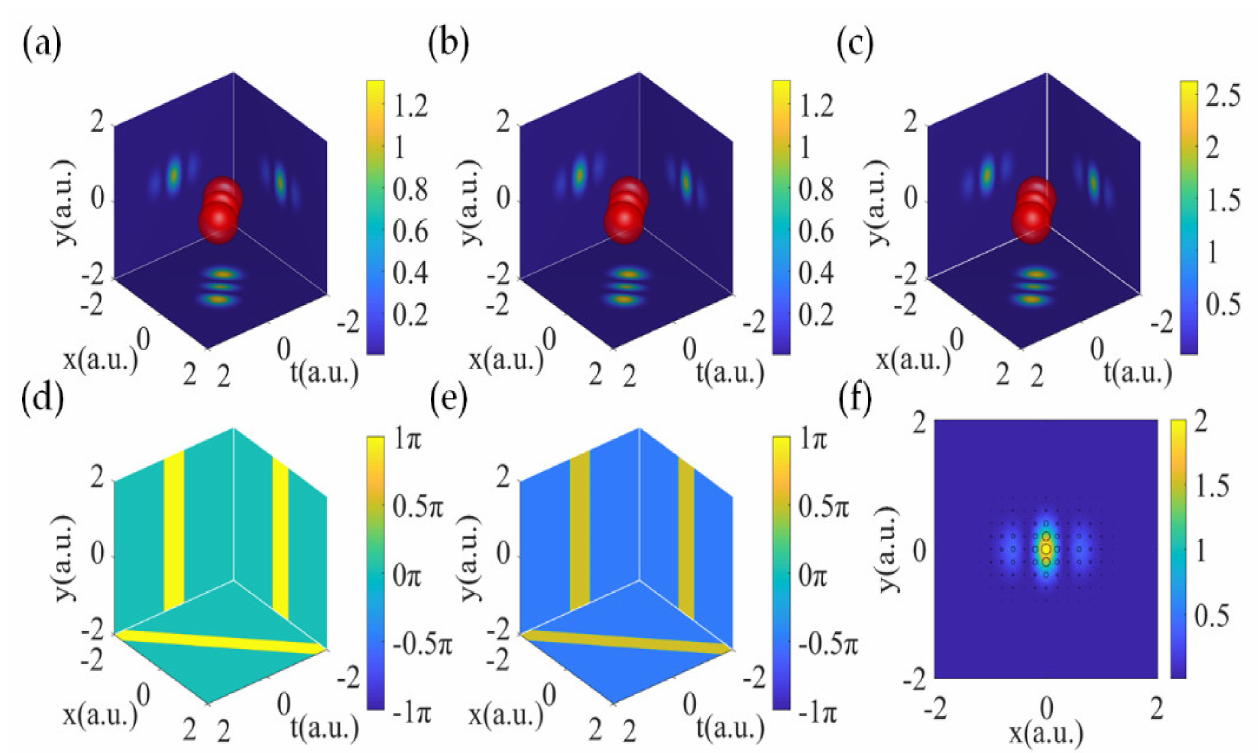
Figure 1. The preconditioned RCP incident wave packet. ( a ) The intensity distributions of the x-polarized component on the three orthogonal planes, combined with an isosurface at 10% of its peak intensity. ( b ) The intensity distributions of the y-polarized component on the three orthogonal planes, combined with an isosurface at 10% of its peak intensity. ( c ) The intensity distributions of the entire incident wave packet on the three orthogonal planes, combined with an isosurface at 10% of its peak intensity. ( d ) The phase distribution of the x-polarized component on the three orthogonal planes. ( e ) The phase distribution of the y-polarized component on the three orthogonal planes. ( f ) The polarization distribution of the preconditioned incident wave packet in the x–y